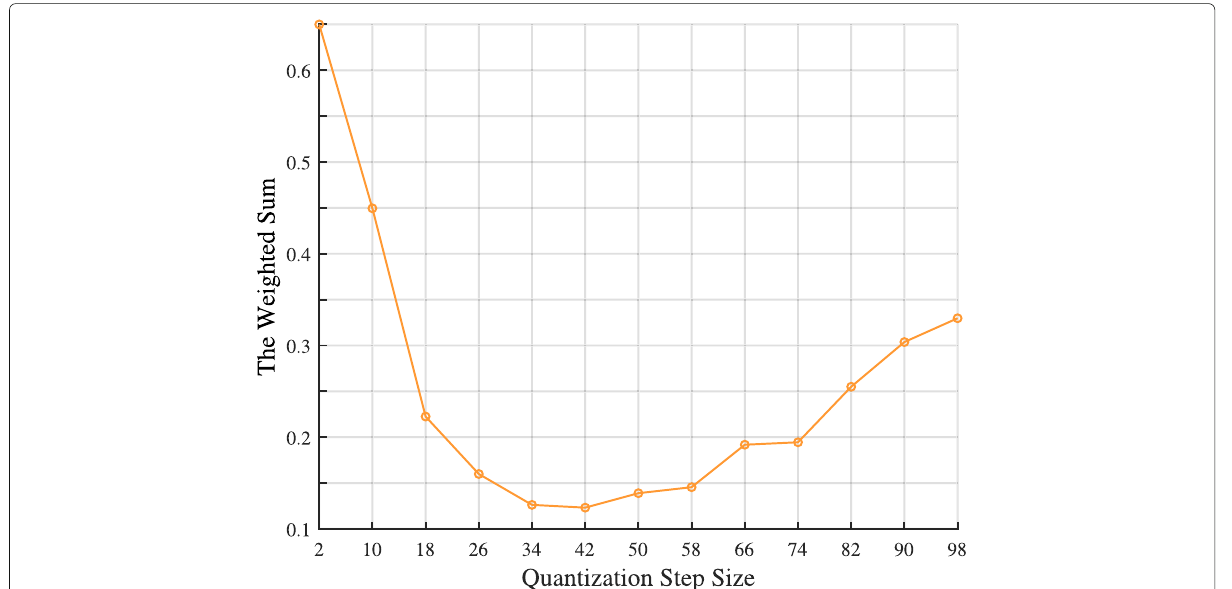
Fig. 11 The weighted sum of MSE and probability of incorrect QIM decoding under the block size of 16 × 16. The MSE and probability of incorrect QIM decoding are normalized to [0,1]. The weight of MSE is set as 0.35, and the weight of incorrect QIM decoding probability is set as